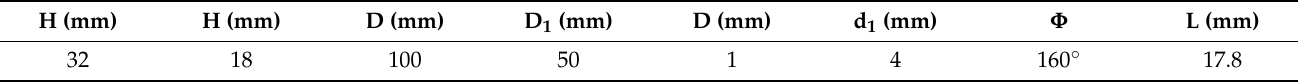
Table 1. Parameters of the vortex suction cup (unit: mm).